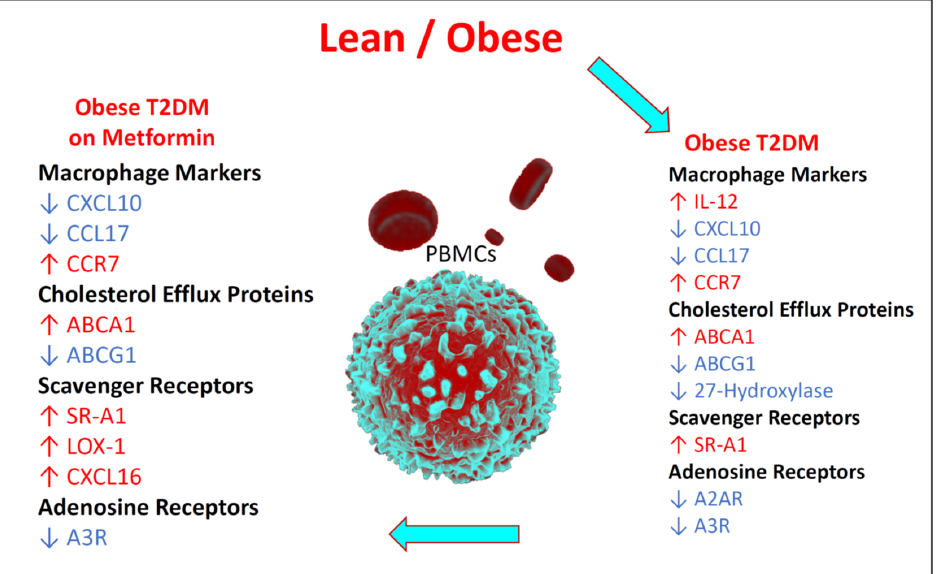
Figure 6. Summary of mRNA expression of all biomarkers examined in this study.